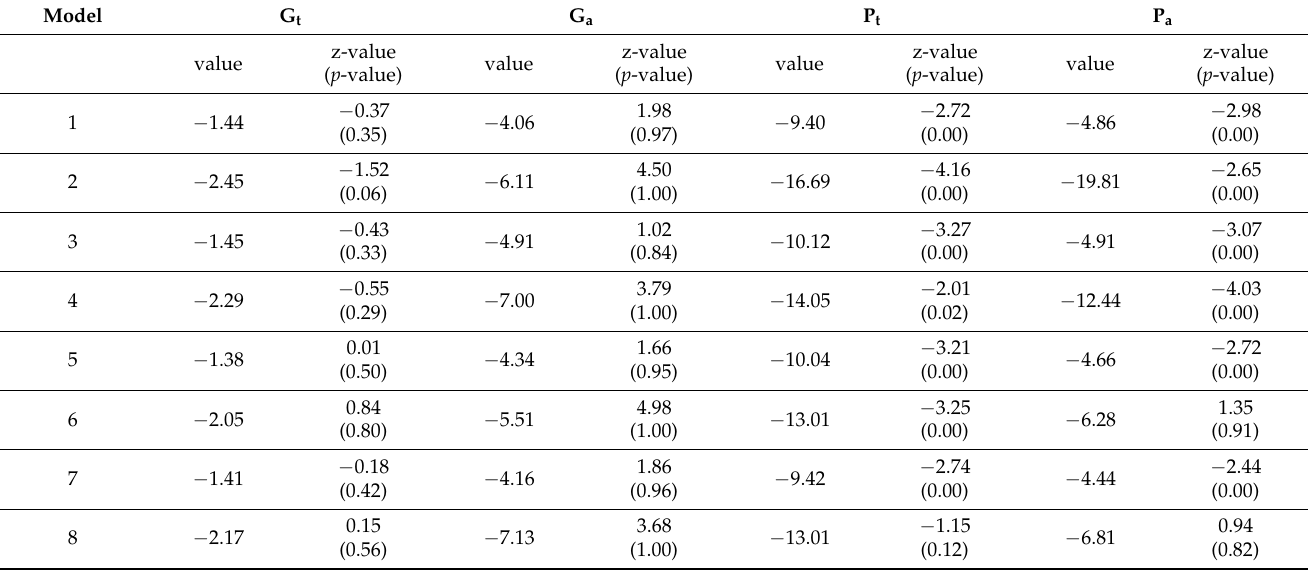
Table 3. Results of Westerlund panel cointegration test (with constant and